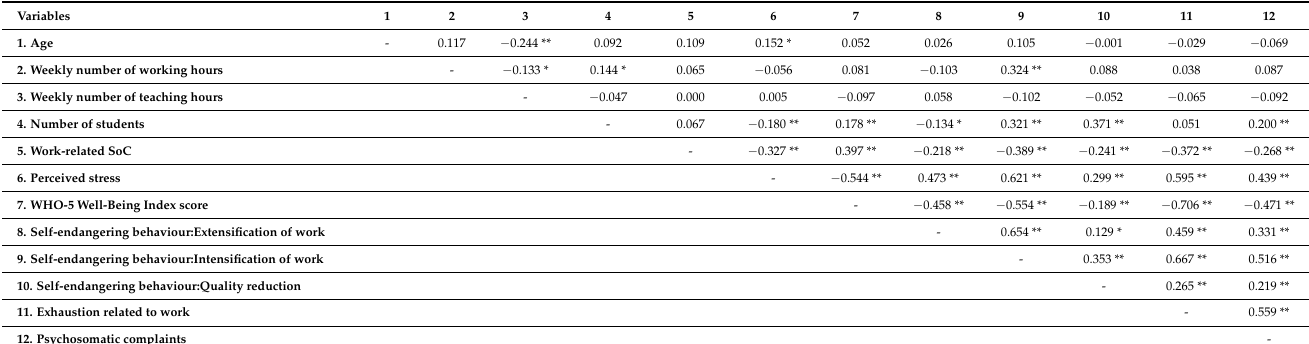
Table 2. Intercorrelations between key variables.